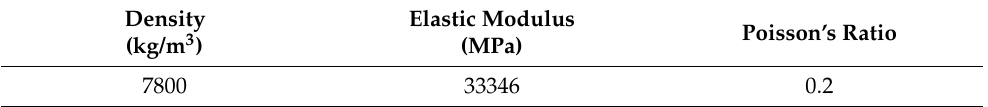
Table 7. Steel load cell